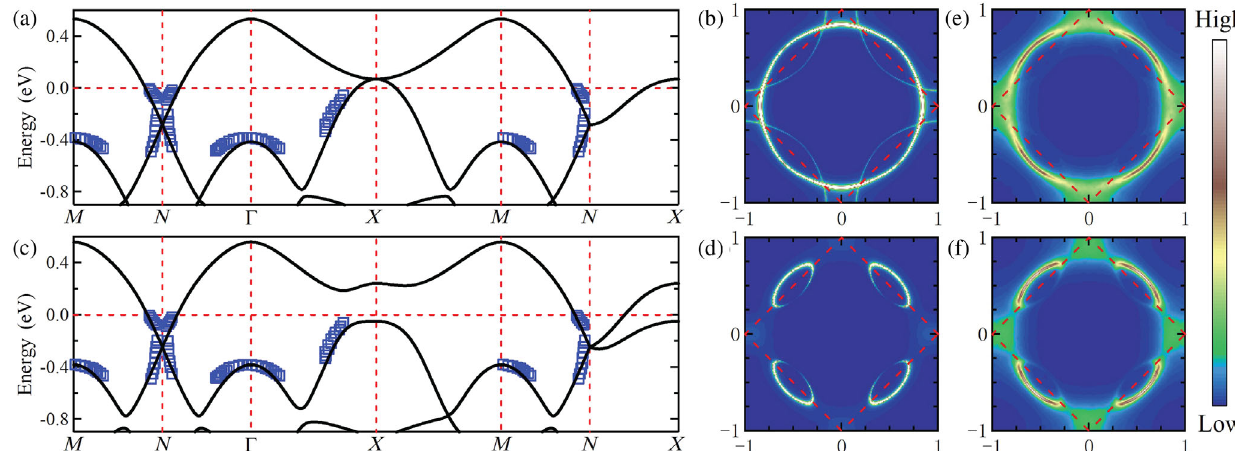
FIG. 4. The PM phase at x ¼ 0 . 1 and ð U; J Þ ¼ ð 1 . 4 ; 0 Þ eV. (a),(b) Band dispersion in the absence of H Δ , i.e., without d -PSCO (black lines) and the spectral intensity of the corresponding FS. (c),(d) Band dispersion in the presence of d -PSCO for Δ the gapping of the BTP at X (red lines) and the spectral intensity of the corresponding FS. (e) FS spectrum in the presence of disorder ¼ 0 and ε ¼ 60 meV, showing the Fermi arcs. (f) FS spectrum in the disordered d -PSCO with Δ with Δ d ARPES data [21] are superimposed as open blue